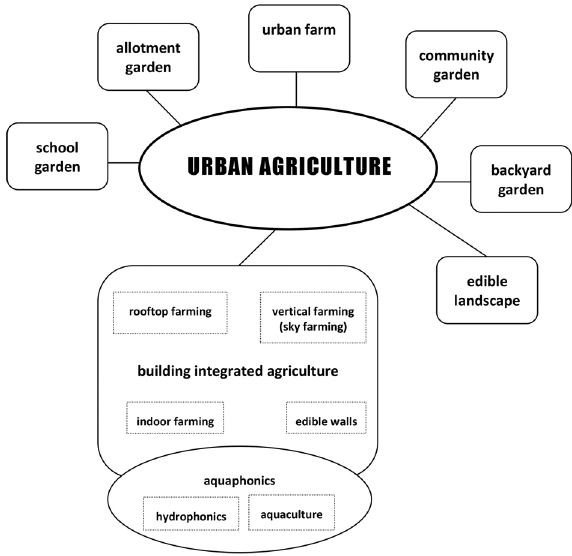
Fig. 1. Scope of urban